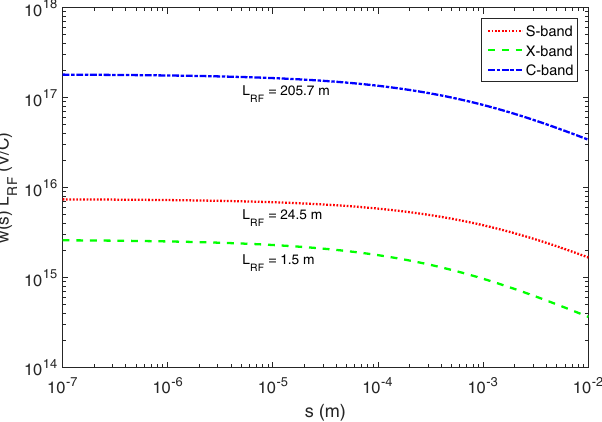
FIG. 2. Product of the point-charge wake function with the full length of the S -band boosters (dotted red), the X -band linearizer (dashed green), and C -band linacs (dashed dotted blue) of